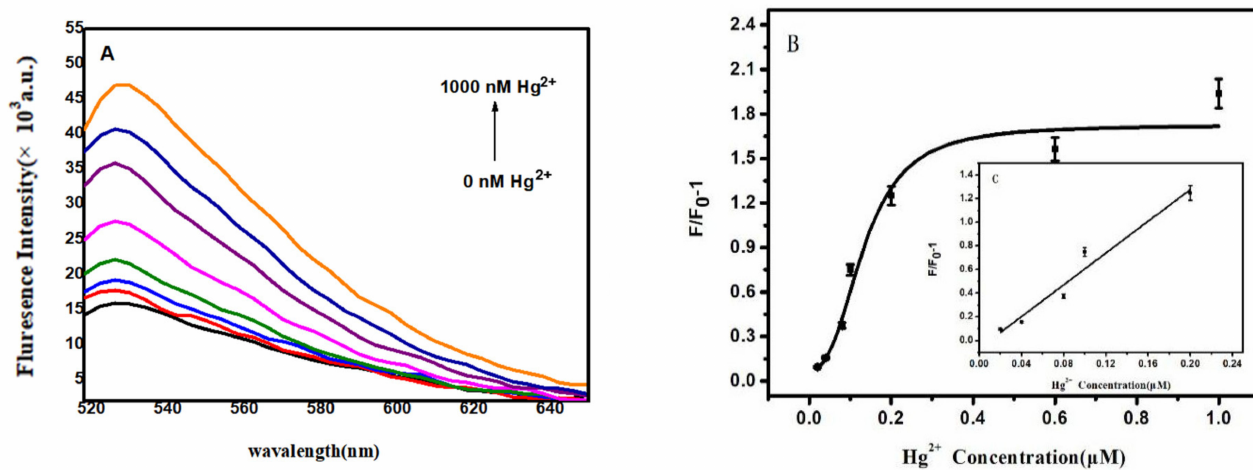
Figure 1. ( A ) The fluorescence intensity of GODNA sensor (DNA probe 1) after adding different concentrations of Hg 2+ . ( B ) The value of F/F 0 -1 after adding different concentrations of heavy metal mercury. F and F 0 were the fluorescence intensity of after adding Hg 2+ , and before adding Hg 2+ . ( C ) The illustration showed a linear relationship between low concentrations of Hg 2+ and F/F 0